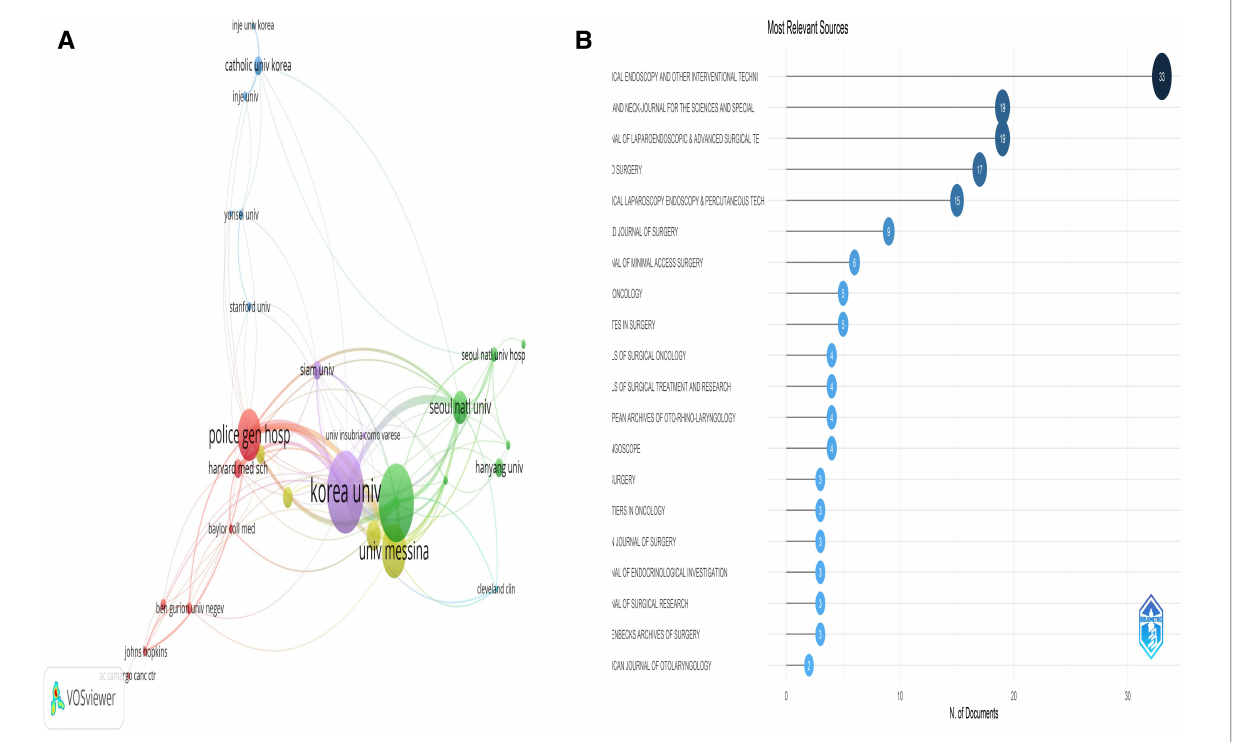
FIGURE 3 ( A ) organization co-occurrence network diagram. The size of the circle represents the number of documents issued by the organization, and the connection represents the connection between organizations. ( B ) Publications of top 20 related magazines.